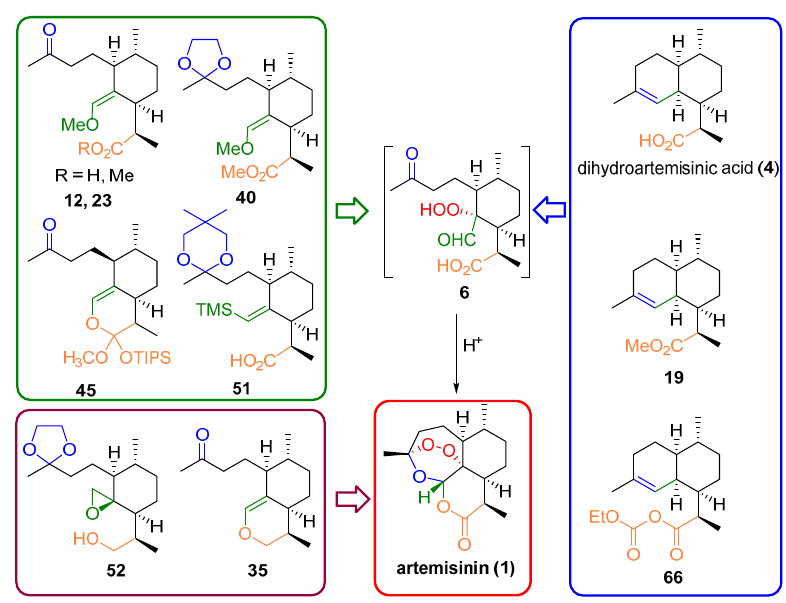
Scheme 22. Summary of key-precursors in different approaches.